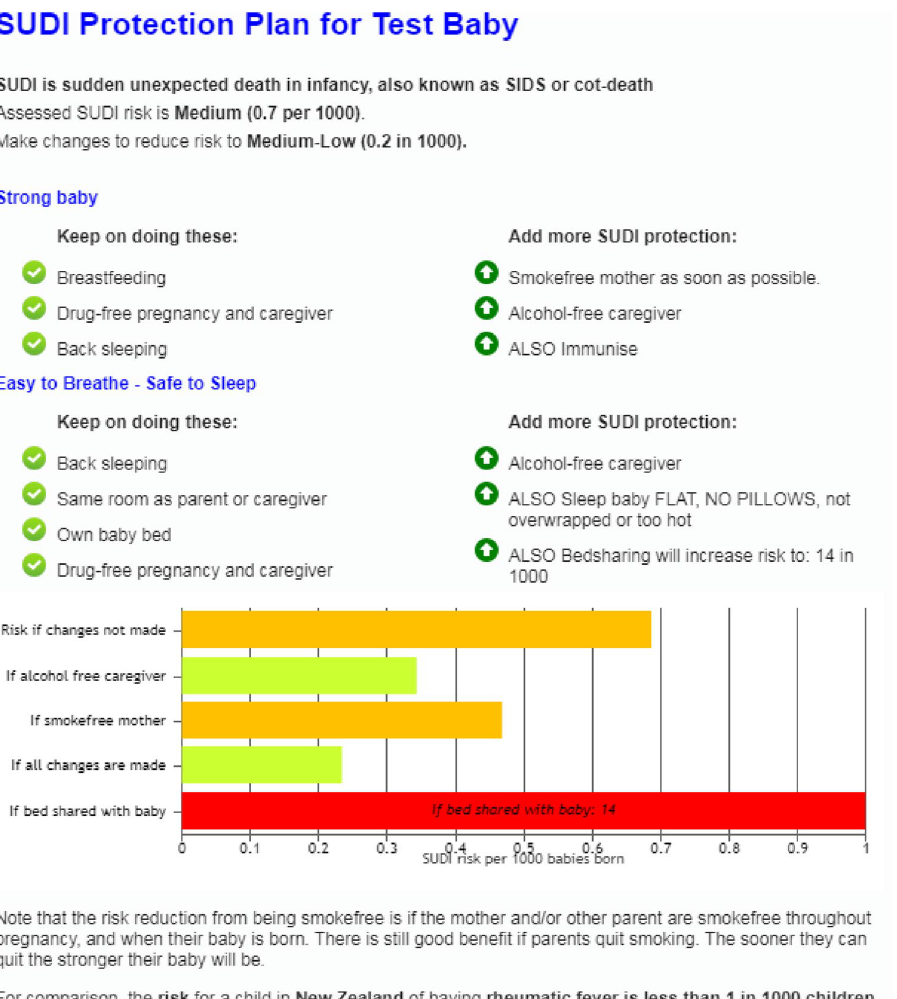
Figure 4. An example of the revised Safe Sleep Calculator result output for a 2980 g female infant, first baby for a 19-year-old mother who smokes, drinks two standard drinks 2–3 nights per week and sleeps her baby on their back in a cot. The result also shows the risk if she did bedshare. Note the difficulty showing the increased risk (14 per 1000) on the chart with